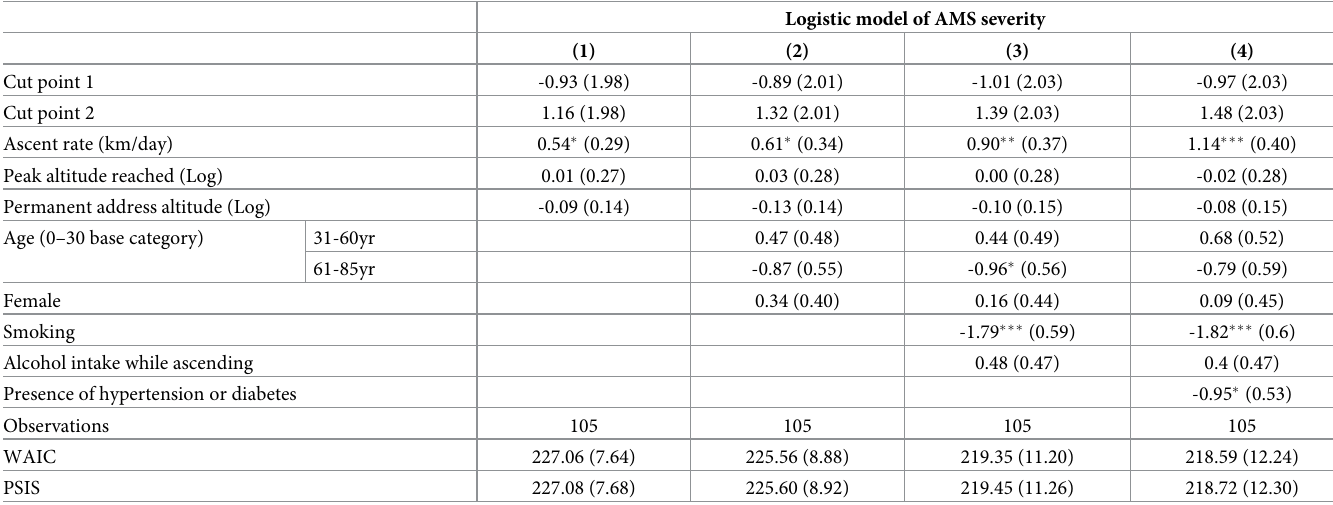
Table 2. Bayesian ordered logistic model of AMS